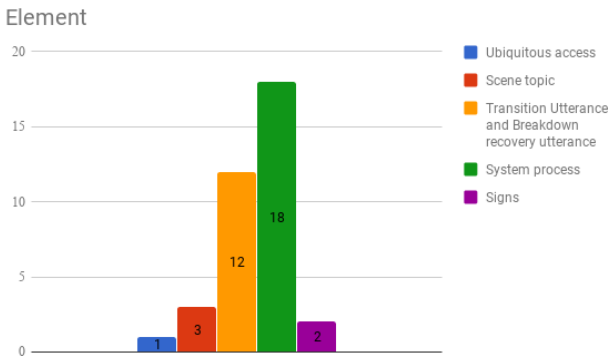
Figure 10. Number of defects of each element.